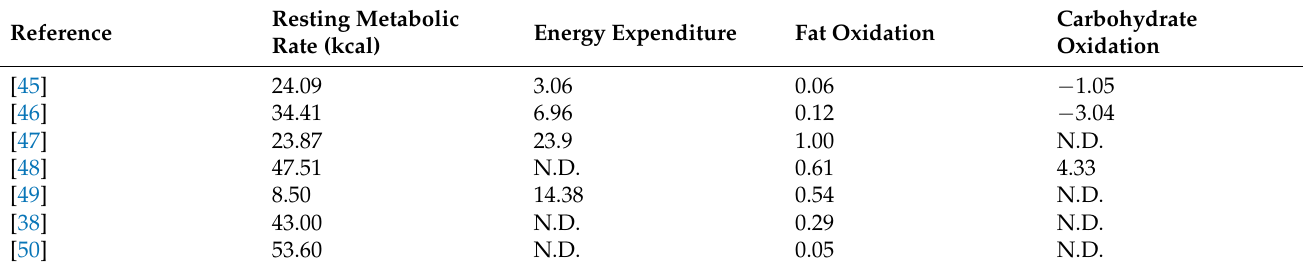
Table 1. Weighted mean difference in the resting metabolic rate (kcal/day), energy expenditure (kcal/day), fat oxidation (g/hour), and carbohydrate oxidation (g/hour), in seven clinical studies with dietary hot pepper (capsaicin) [45–47] or non-pungent capsinoid [38,48–50]. These studies reported a modest but consistent increase in the resting metabolic rate that may be attributed to a rise in fat oxidation, with no difference between hot pepper and mild pepper